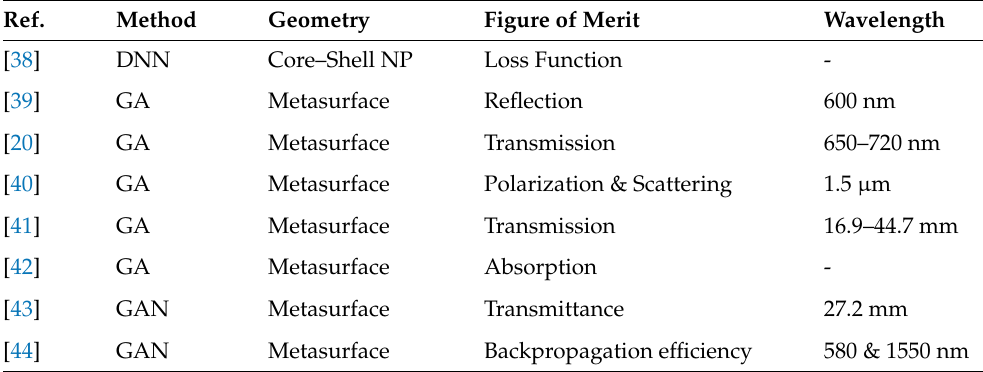
Table 2. Recent studies focused on the inverse design and topology optimization of different photonic components using different methods such as deep neural networks (DNNs), the genetic algorithm (GA), and the generative adversarial network (GAN).